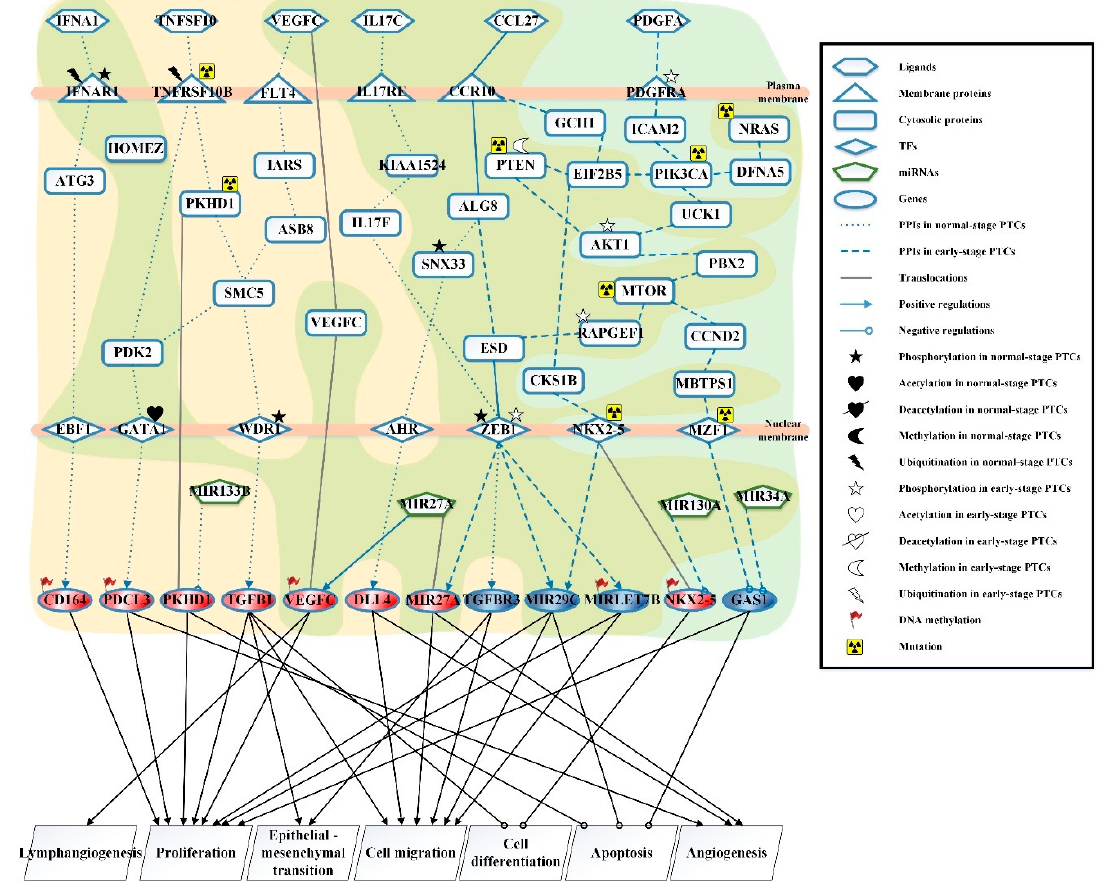
Figure 2. The core signaling pathways are obtained by projecting core GENs to KEGG pathways to investigate the carcinogenic progression mechanism from early-stage thyroid cancer cells to late-stage papillary thyroid cancer cells. The blue dotted lines represent the signaling pathways in early-stage of thyroid cells; the blue dashed lines indicate the signaling pathways in late-stage of PTC; the blue solid lines denote the signal pathways in both stage; the gray solid lines represent translocation; the blue arrow head of lines represents upregulation; the blue circle head of lines represents downregulation; the black arrow head of solid lines represents activating cellular function; the black circle head of solid lines represents inhibiting cellular function; the red gene nodes indicate a higher gene expression in late-stage PTC cells compared with early-stage cells; the blue gene nodes indicate a lower gene expression in late-stage PTC cells compared with early-stage PTC cells; the orange background covers the cellular molecules in early-stage of thyroid cancer cells; the green background covers the cellular molecules in late-stage of thyroid cancer cells.